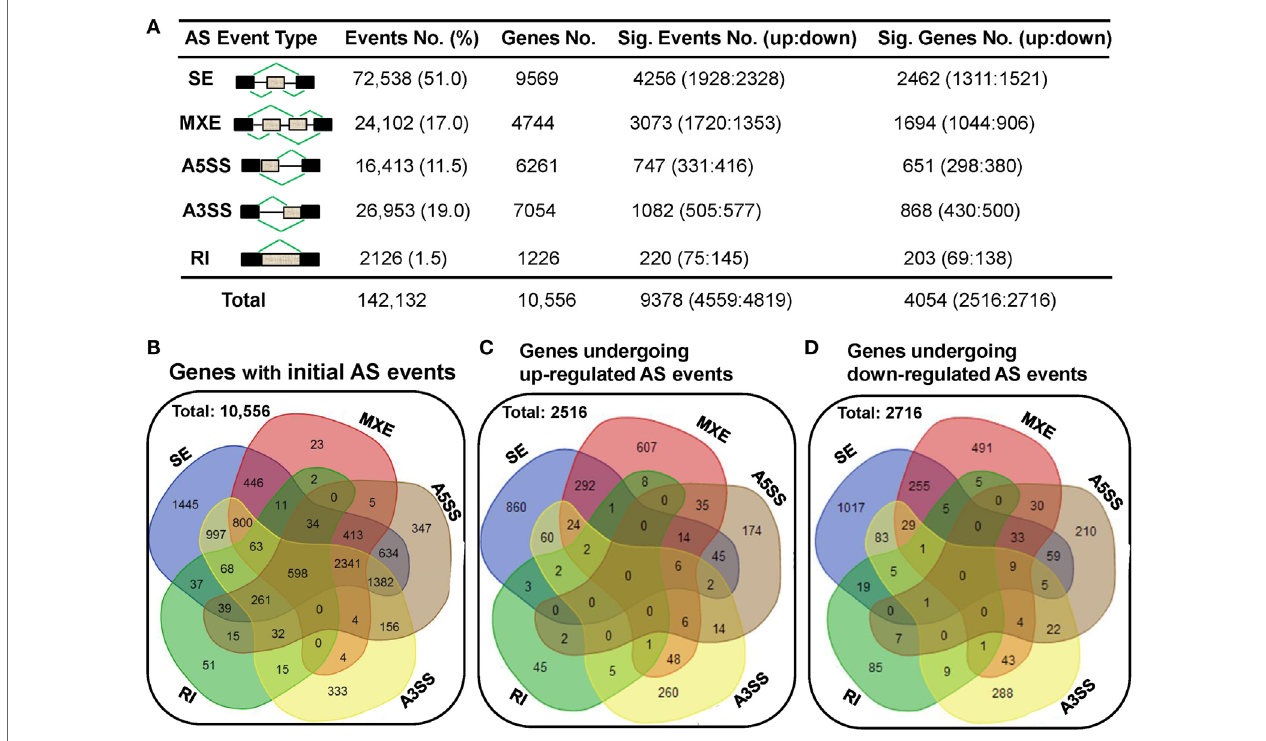
FigUre 6 | A comparable number of upregulated and downregulated AS events is detected in human dCD8 T cells with respect to autologous pCD8 T cells. (a) Summarization of the numbers of initial AS events, statistically significant AS events and of the genes these events belong to. Column 1 illustrates traditional classification of the five most common types of AS events that have been investigated (black box, exon; gray box, intron). Columns 2–5 represent the number of AS events or genes of each type: (2) the initial AS events detected in the combined samples of pCD8 and dCD8 T cells with their frequency among total AS events; (3) genes the initial AS events belong to; (4) statistically significant AS events (FDR < 0.05 with | ΔΨ | > 0.05 between samples) with upregulated (FDR < 0.05 with ΔΨ > 0.05) and downregulated (FDR < 0.05 with ΔΨ < − 0.05) events in human dCD8 versus pCD8 T cells; (5) genes showing the differentially expressed AS events. (B) Venn diagram of genes showing the five types of initial AS events (including SE, MXE, A5SS, A3SS, and RI) in the combined samples of pCD8 and dCD8 T cells. (c,D) Venn diagram of genes displaying upregulated [ (c) , FDR < 0.05 with ΔΨ > 0.05] or downregulated [ (D) , FDR < 0.05 with ΔΨ < − 0.05] SE, MXE, A5SS, A3SS, and RI events in dCD8 T cells with respect to autologous pCD8 T cells. Abbreviations: AS, alternative splicing; SE, skipped exon; MXE, mutually exclusion exons; A5SS, alternative 5’ splice site; A3SS, alternative 3’ splice site; RI, retained intron; %, percentage; No., number; Sig., significant; up, upregulated; down, downregulated; FDR, false discovery